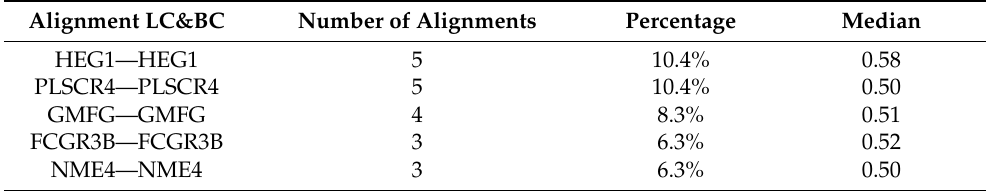
Table 3. Gedevo’s most significant alignments between lung cancer (LC) and breast cancer (BC) sets. Alignment LC&BC Number of Alignments